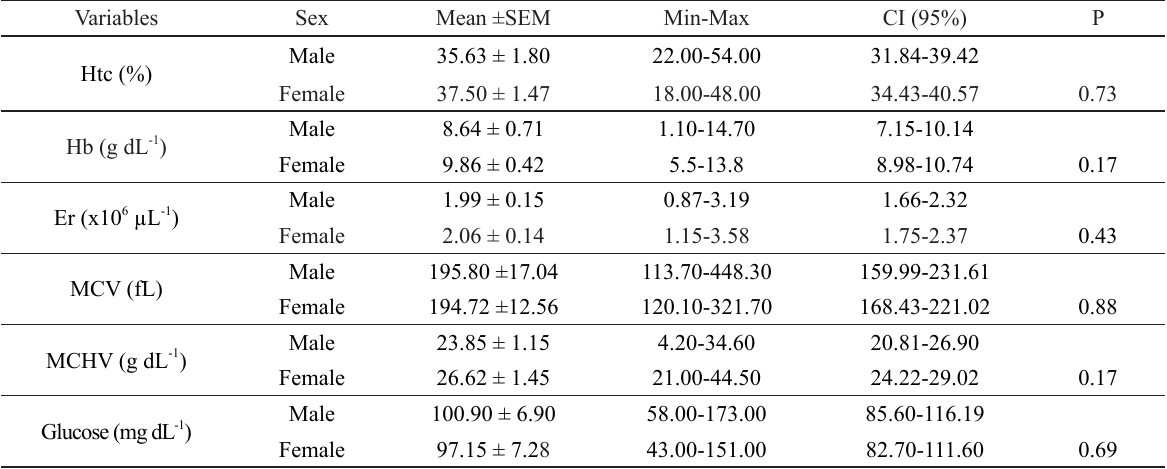
Htc=Hematocrit; Hb=Hemoglobin; Er= Erythrocytes; MCV=mean corpuscular volume; MCHV=mean corpuscular hemoglobin volume; P: Mann-Whitney U